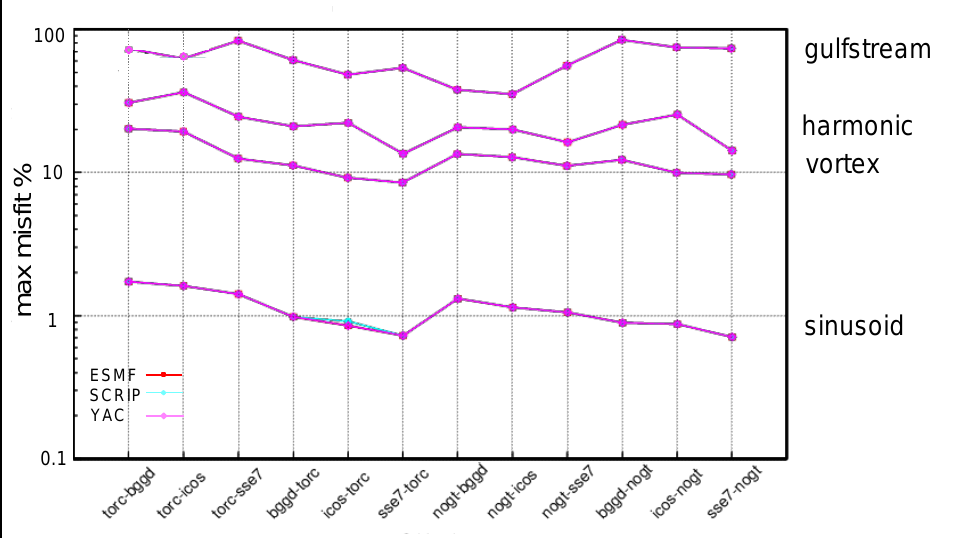
Figure 4. Maximum misfit for the different pairs of grids for the different functions sinusoid, vortex, harmonic, gulfstream for the nearest neighbour algorithm for ESMF, SCRIP and YAC.